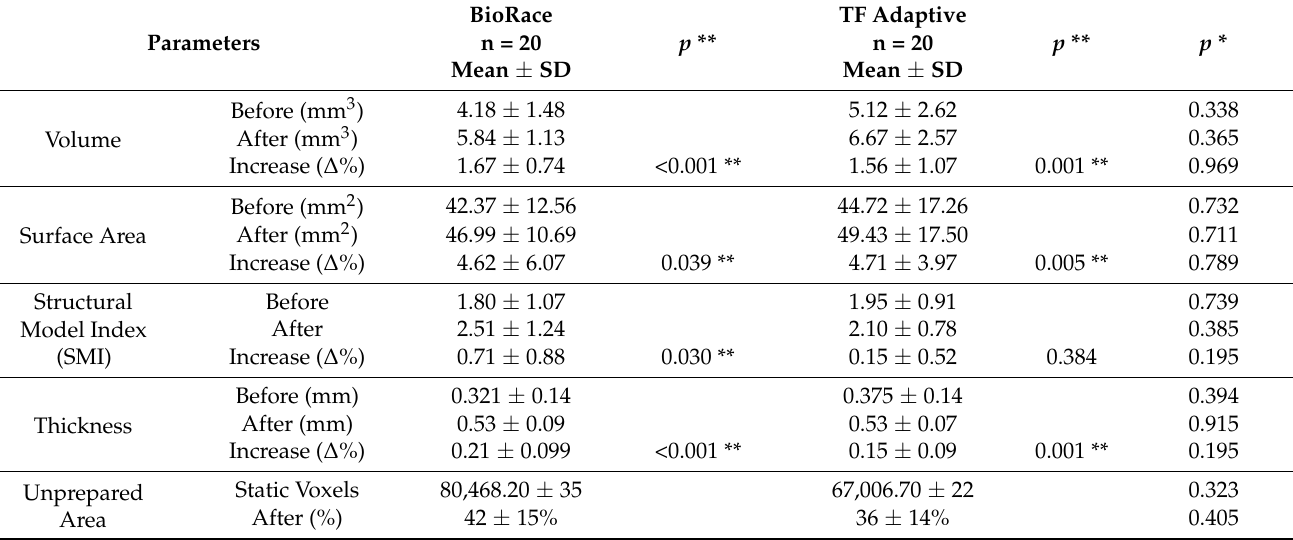
Table 1. Morphometric indices before and after instrumentation of mesial